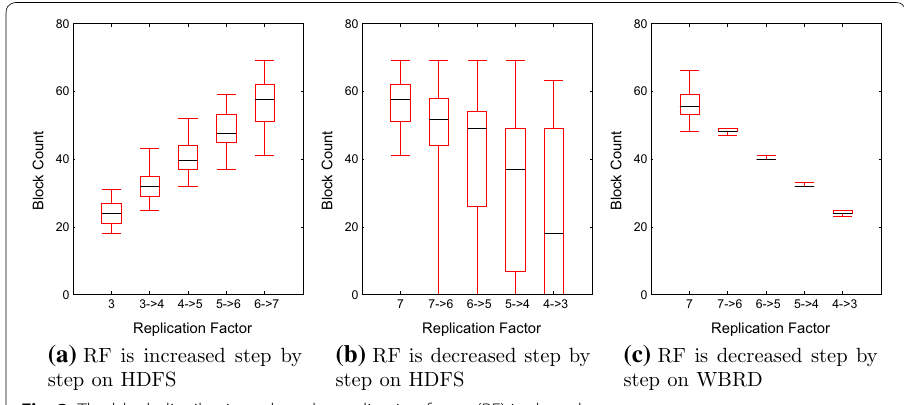
Fig. 3 The block distribution when the replication factor (RF) is